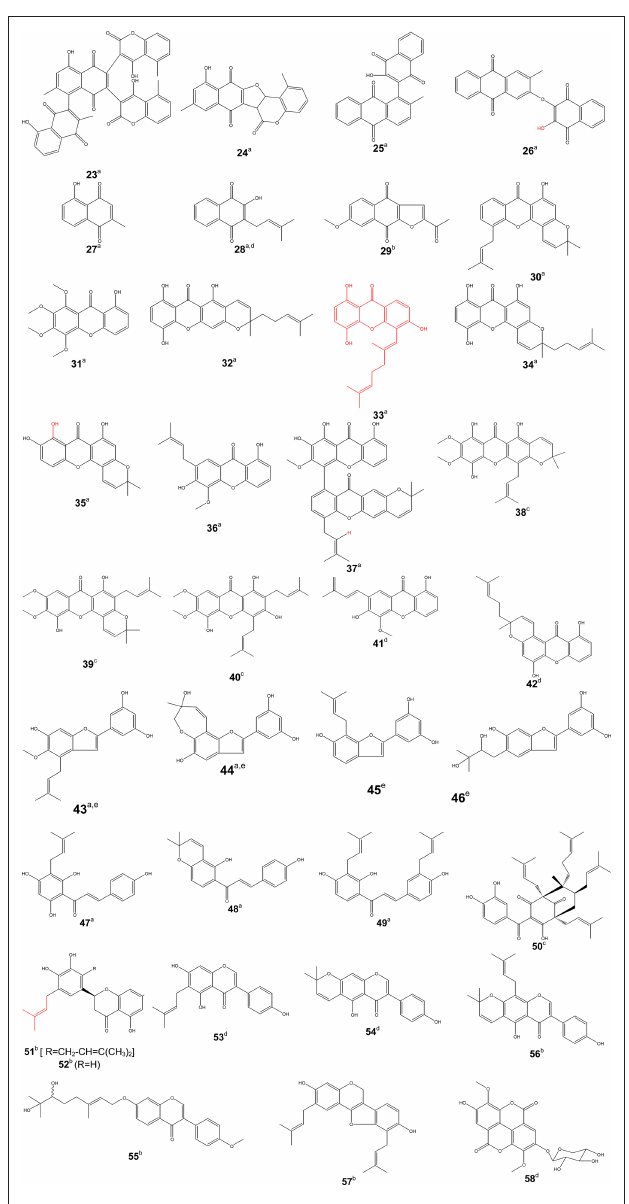
FIgUrE 3 | Bioactive phenolics [quinones (23–29), xanthones (30–42), arylbenzofurans (43–46)]. Activity [(a) antimicrobial, (b) anti-inflammatory, (c) antimalarial, (d) anti-proliferative, (e) antioxidant]. [Chalcones ( 47–49 ), benzophenone ( 50 ), flavone ( 51–52 ), isoflavones ( 53–56 ), pterocarpene ( 57 ), ellagic acid derivative ( 58 )]. Activity [(a) antimicrobial, (b) anti-inflammatory, (c) antimalarial, (d) anti-proliferative, (e)